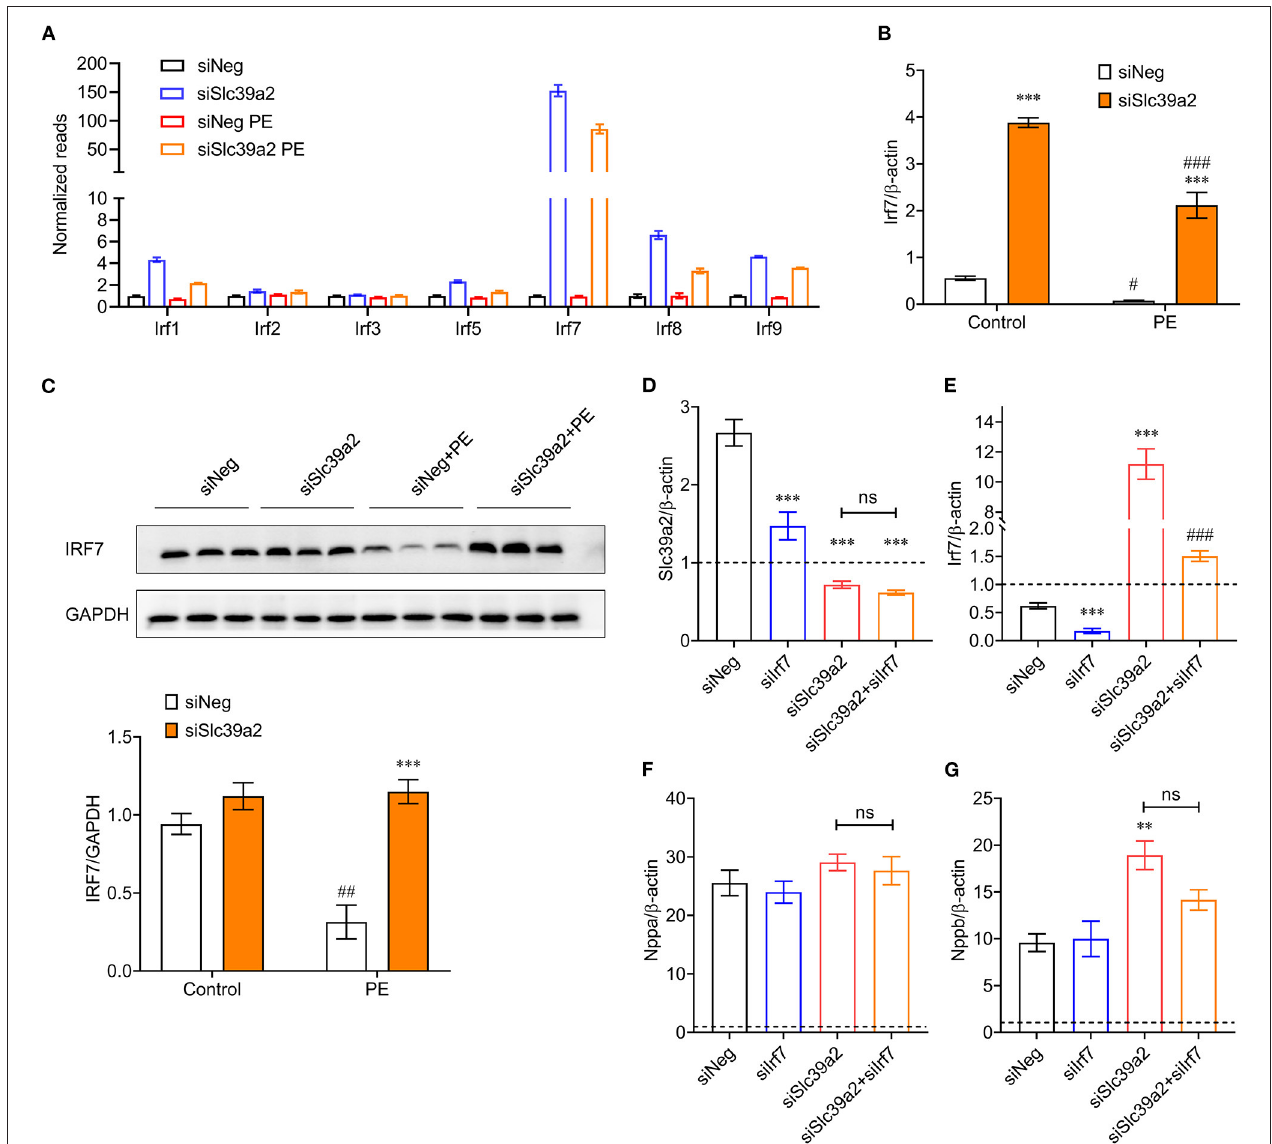
FIGURE 7 | Interplay between SLC39A2 and IRF7 during cardiomyocyte hypertrophy. (A) Reads of IRF family genes (Irf1-9) from RNA-seq data. n = 3. (B) Validation of Irf7 expression by qRT-PCR. *** P < 0.001 vs. siNeg; # P < 0.05, ### P < 0.001 vs. Control. n = 3. (C) Immunoblots (upper) and quantification data (lower) for IRF7 expression at protein level in NRVMs with or without Slc39a2 knockdown and PE treatment. *** P < 0.001 vs. siNeg; ## P < 0.01 vs. Control. n = 3. (D,E) Validation of knockdown efficacy siSlc39a2 (D) and siIrf7 (E) in PE-treated NRVMs. Data were normalized to control group (dotted line). *** P < 0.001 vs. siNeg; ### P < 0.001 vs. Control. n = 3. (F,G) Impact of combined knockdown of Slc39a2 and Irf7 on hypertrophy markers, Nppa (F) and Nppb (G) . ** P < 0.01 vs. siNeg. n =